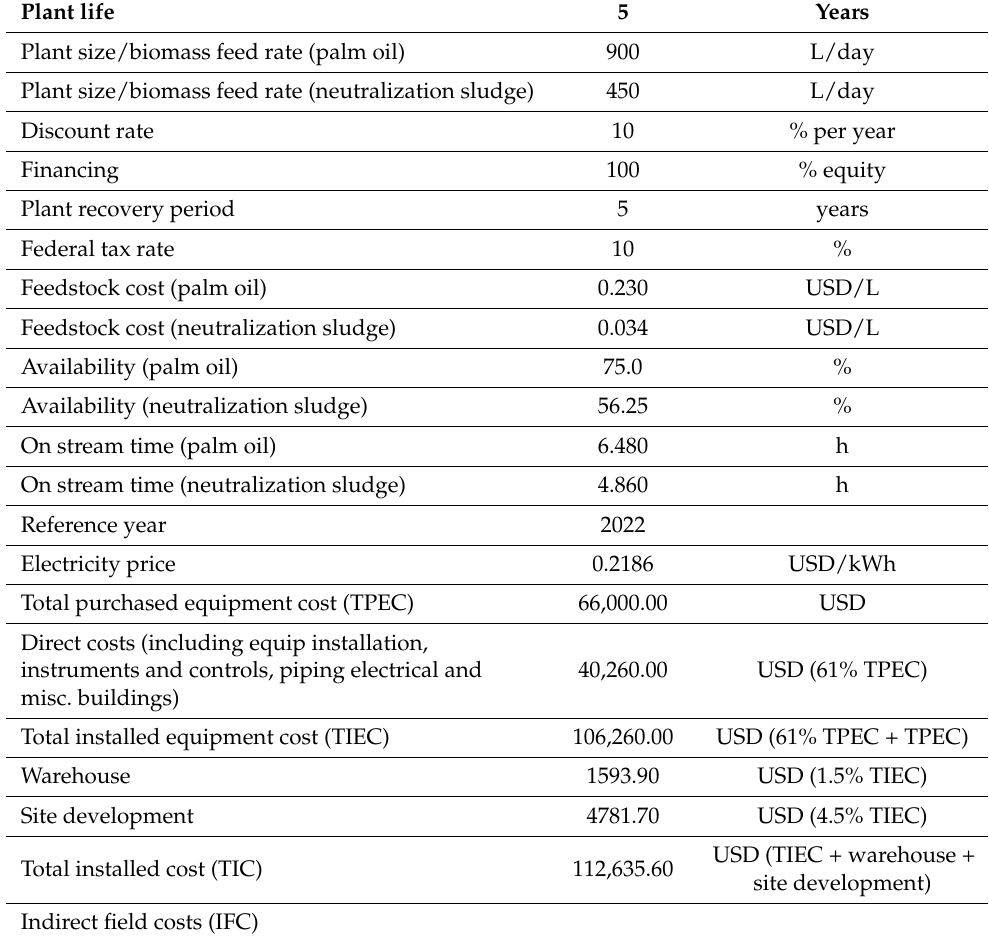
Table 6. Economic parameters for discounted cash flow